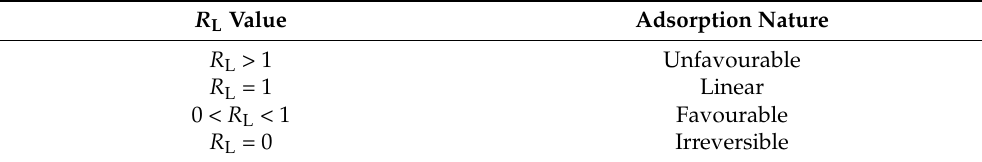
Table 5. The nature of the adsorption